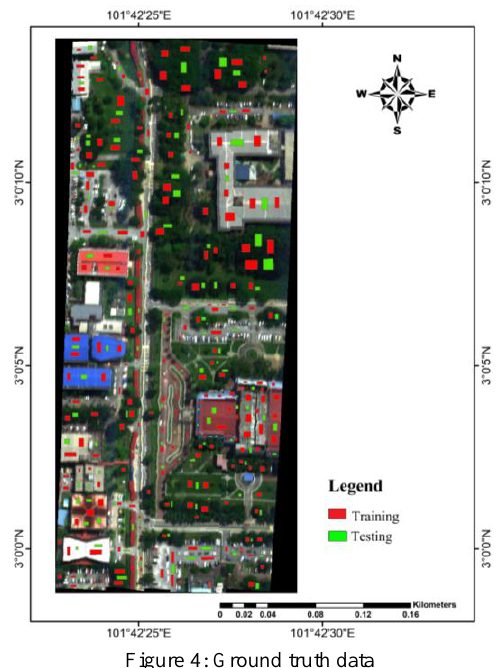
Figure 4: Ground truth data